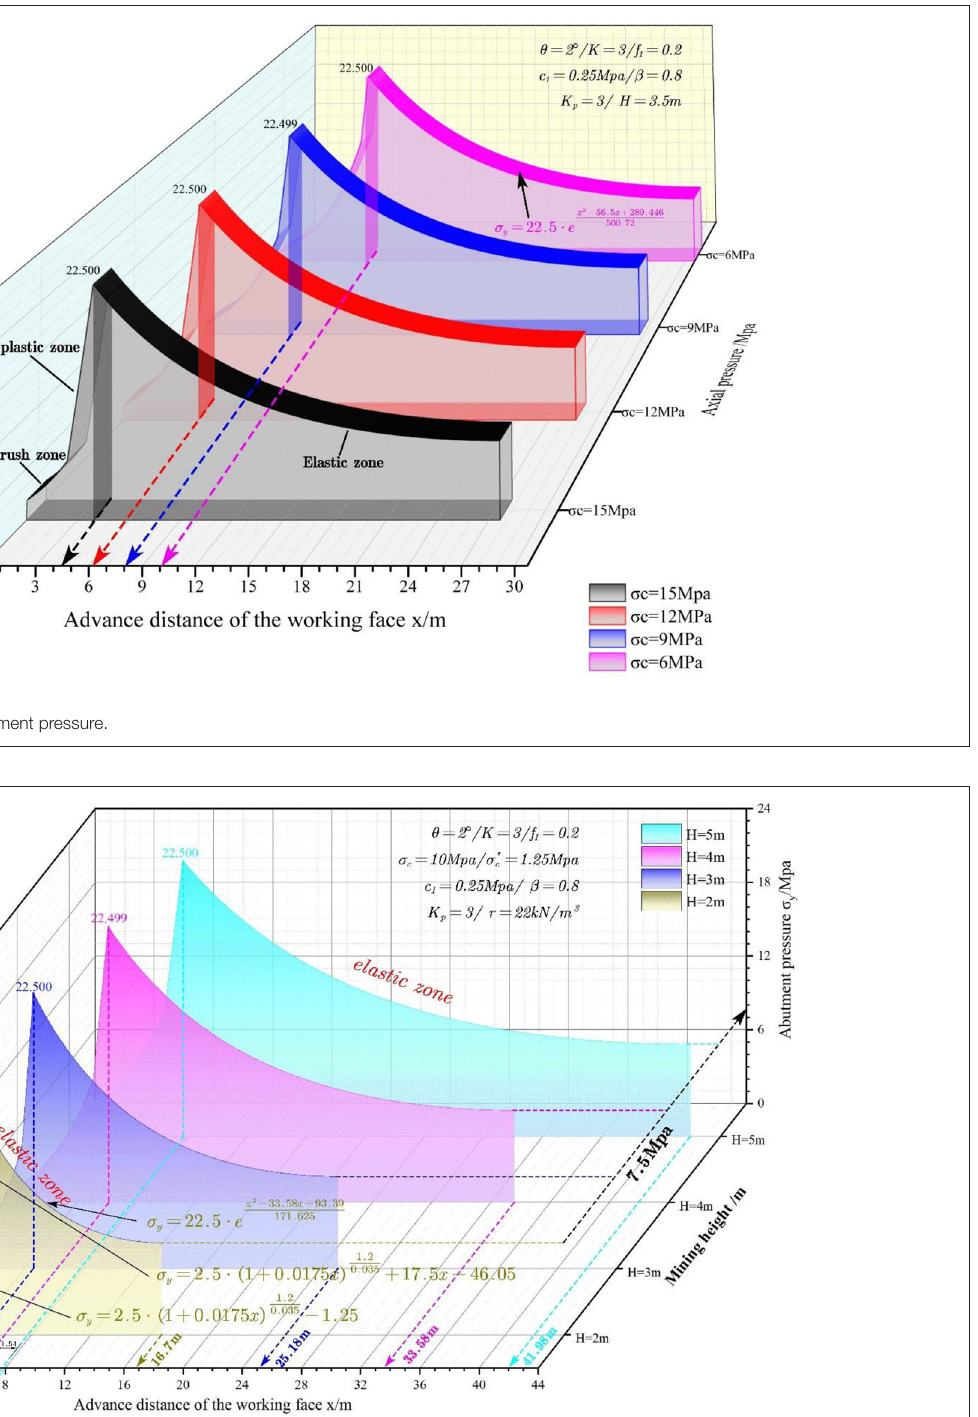
It can be discovered from Figure 10 that the widths of the crushed zone, plastic zone, inelastic zone, and elastic zone increase linearly with the increase in mining